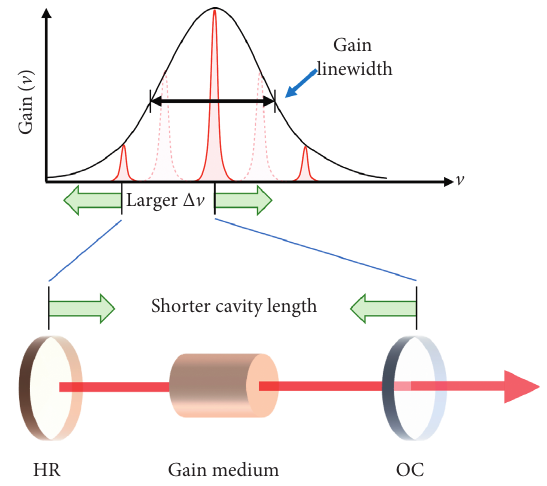
Figure 2: Schematic showing the principle of SLM selection by short cavity method.